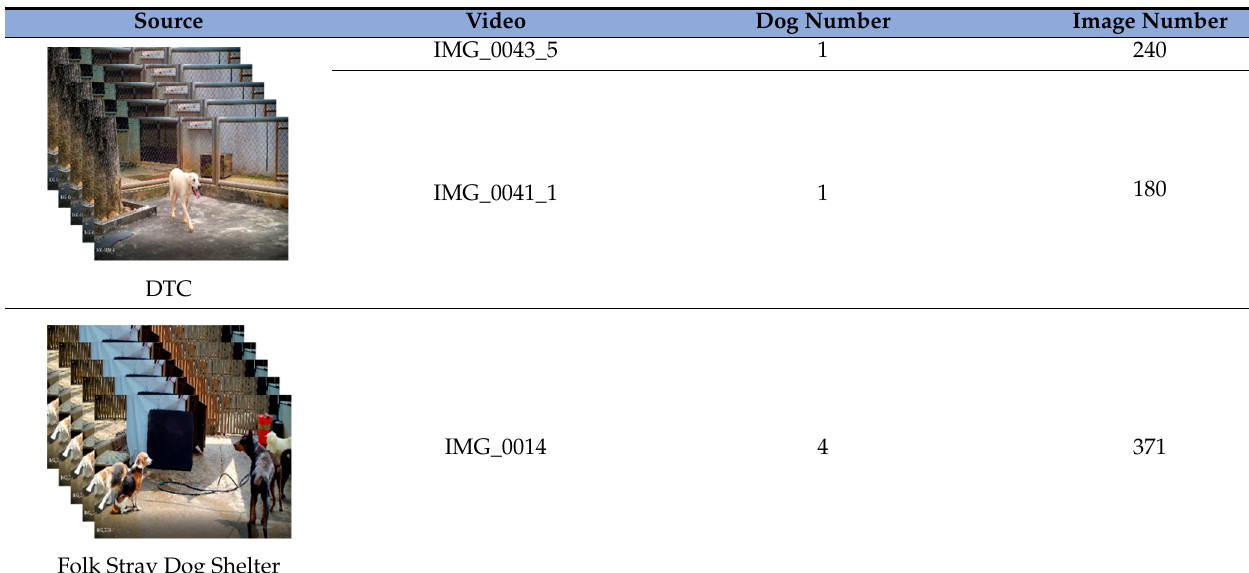
Table 5. Test videos used in dog-tracking experiment.